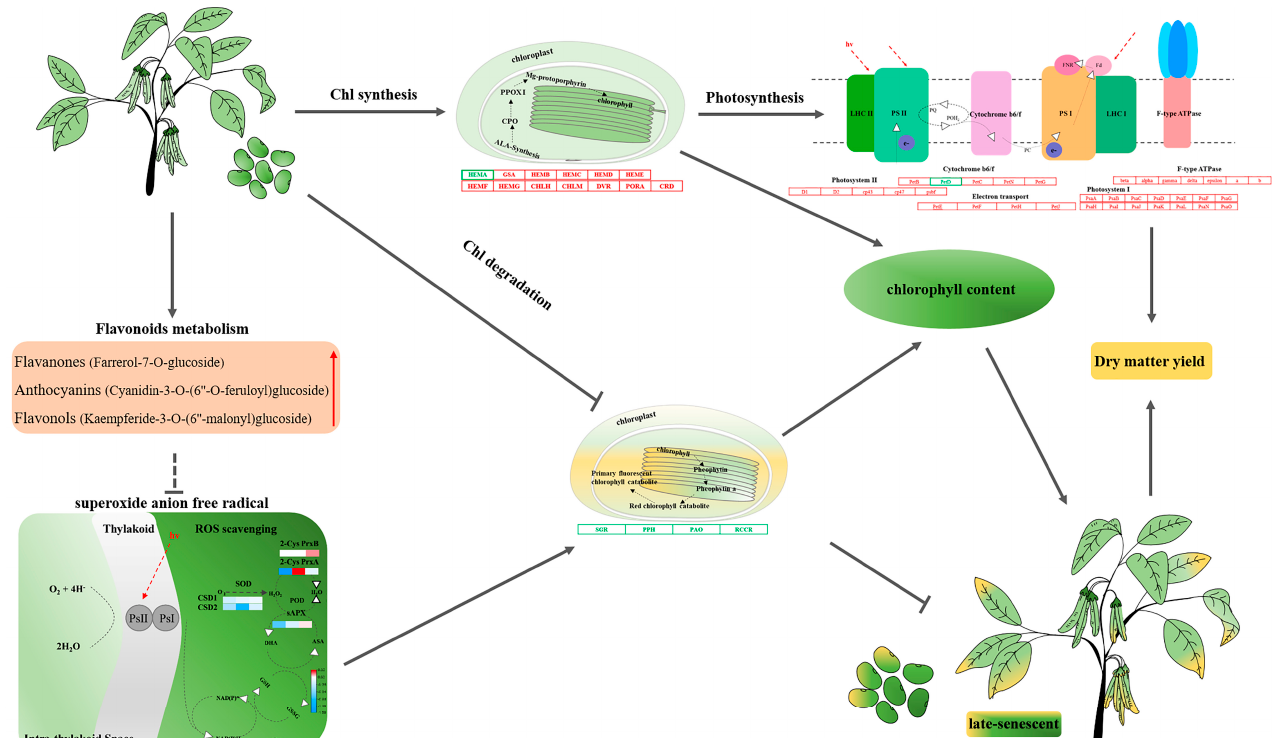
Figure 7. The proposed model affecting the difference of stay-green ability between ZX12 and ZX4 seeds at mature stages. The font in red indicates that they are positively regulated in ZX12; red boxes represent up-regulation; green boxes represent down-regulation; and the arrow represents promotion, and the T represents inhibition.